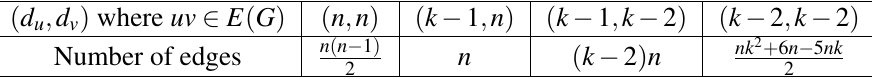
Table 1 The size partition of G